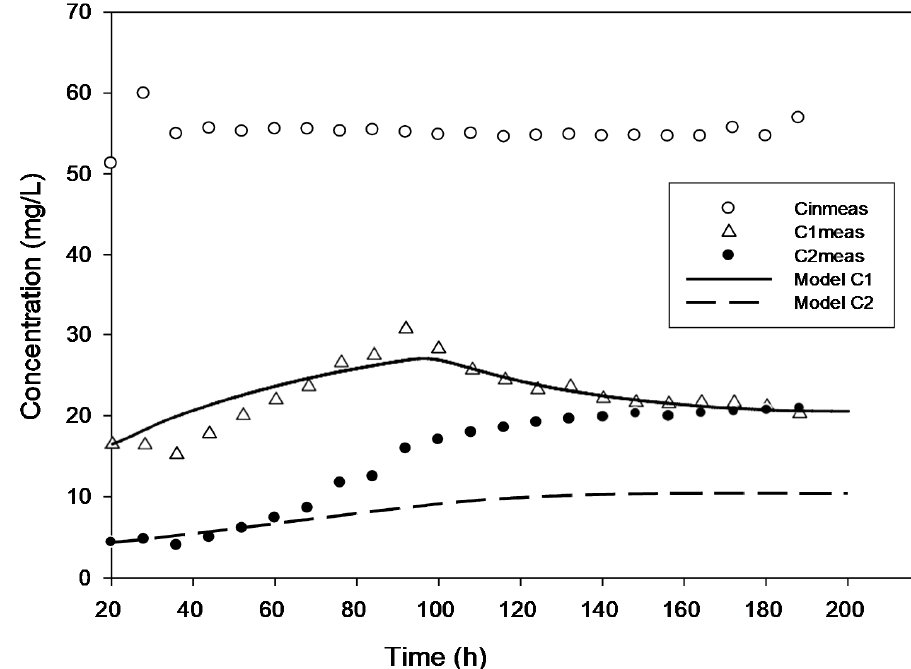
Figure 2. Model validation for the concentration of 100 mg·L − 1 .